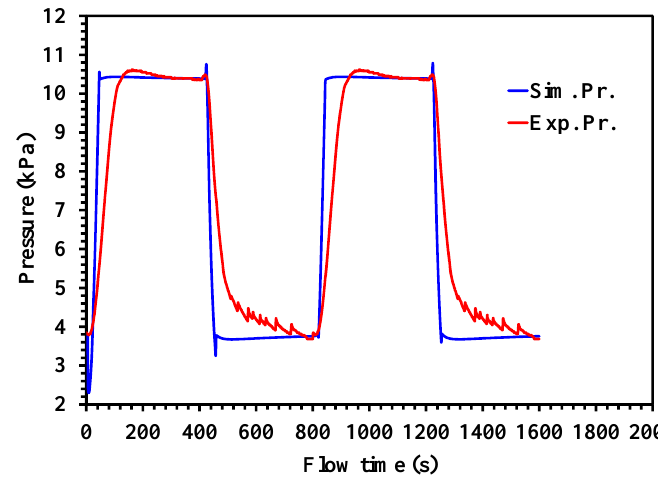
Figure 5. Comparison of pressure change in the adsorber/desorber bed: experimental (red) and simulated (blue).